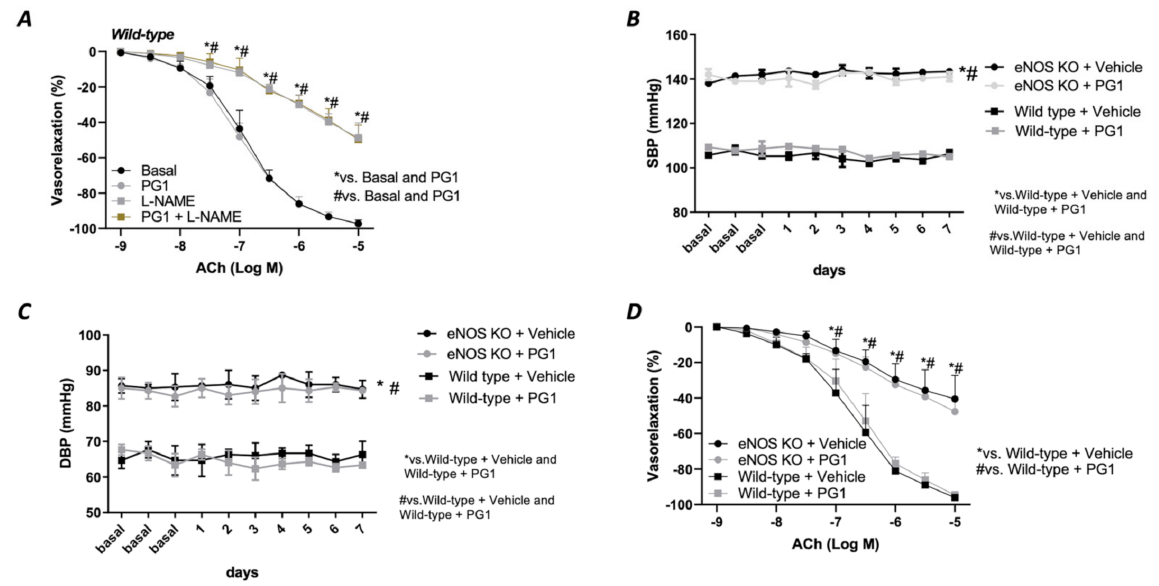
Figure 5. ( A ) Evaluation of ex vivo vascular reactivity of PG1 (100 µ M for 1 h) in wild-type mice treated with eNOS inhibitor, L-NAME (300 µ M for 30 min). ( B , C ) Tail-cuff measurement of systolic and diastolic blood pressure in wild-type and eNOS knock-out mice gavage-treated with vehicle or PG1 (10 mg/Kg) for 7 days. ( D ) Evaluation of endothelial-dependent relaxation in mesenteric arteries obtained from wild-type and eNOS knockout mice excised at the end of in vivo treatment (7th day) with vehicle or